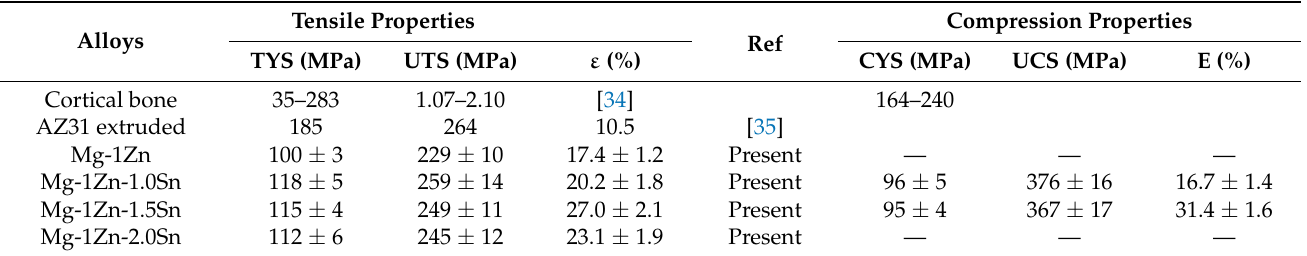
Table 2. The mechanical properties of Mg-Zn-Sn alloys, bone, and AZ31 extruded alloys.